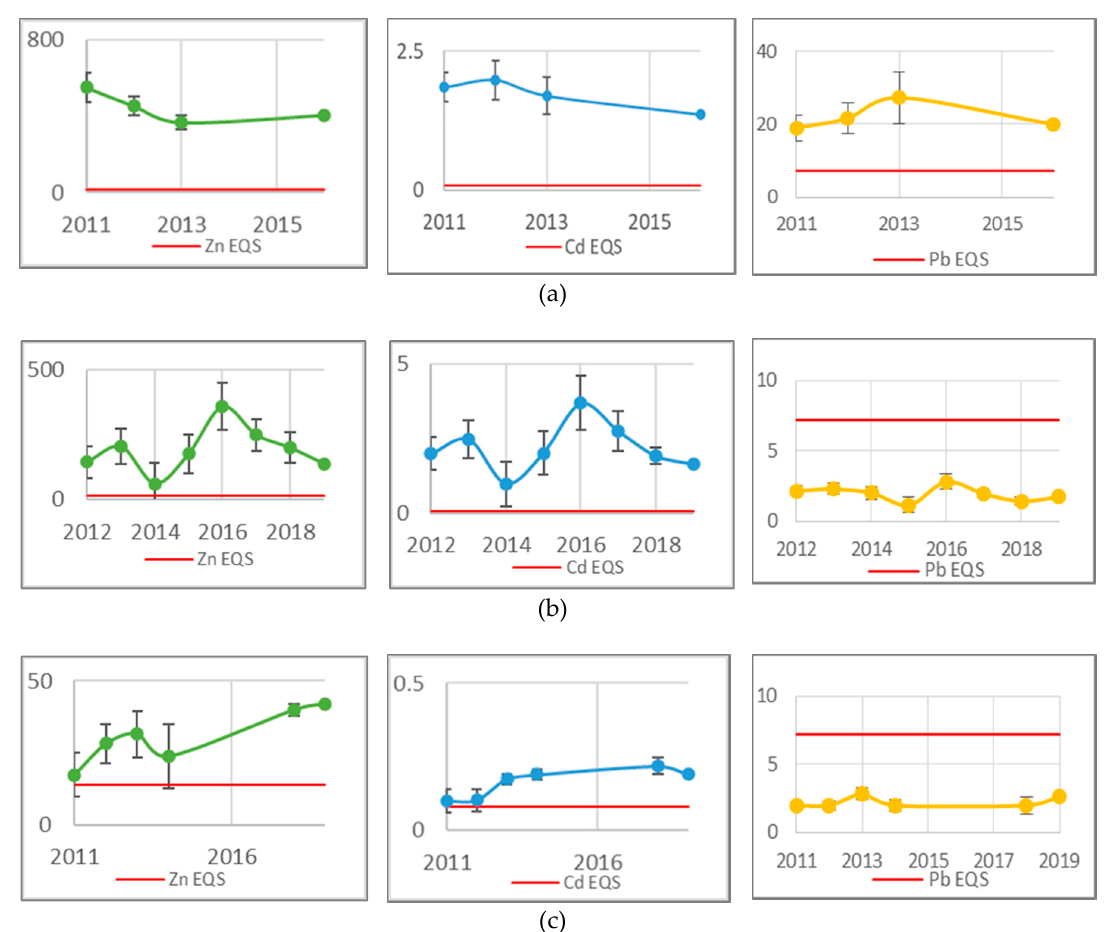
Figure 7. Dissolved metal concentrations (µg/L) compared with specific EQS along sample points of the river Teign. ( a ) concentrations of Zn, Cd and Pb at Rookery brook from 2011 to 2016, ( b ) metal concentrations downstream at Beadon brook from 2012 to 2019, ( c ) concentrations from Chudleigh bridge from 2011 to 2019. Data collected from the Environment Agency water quality archive.